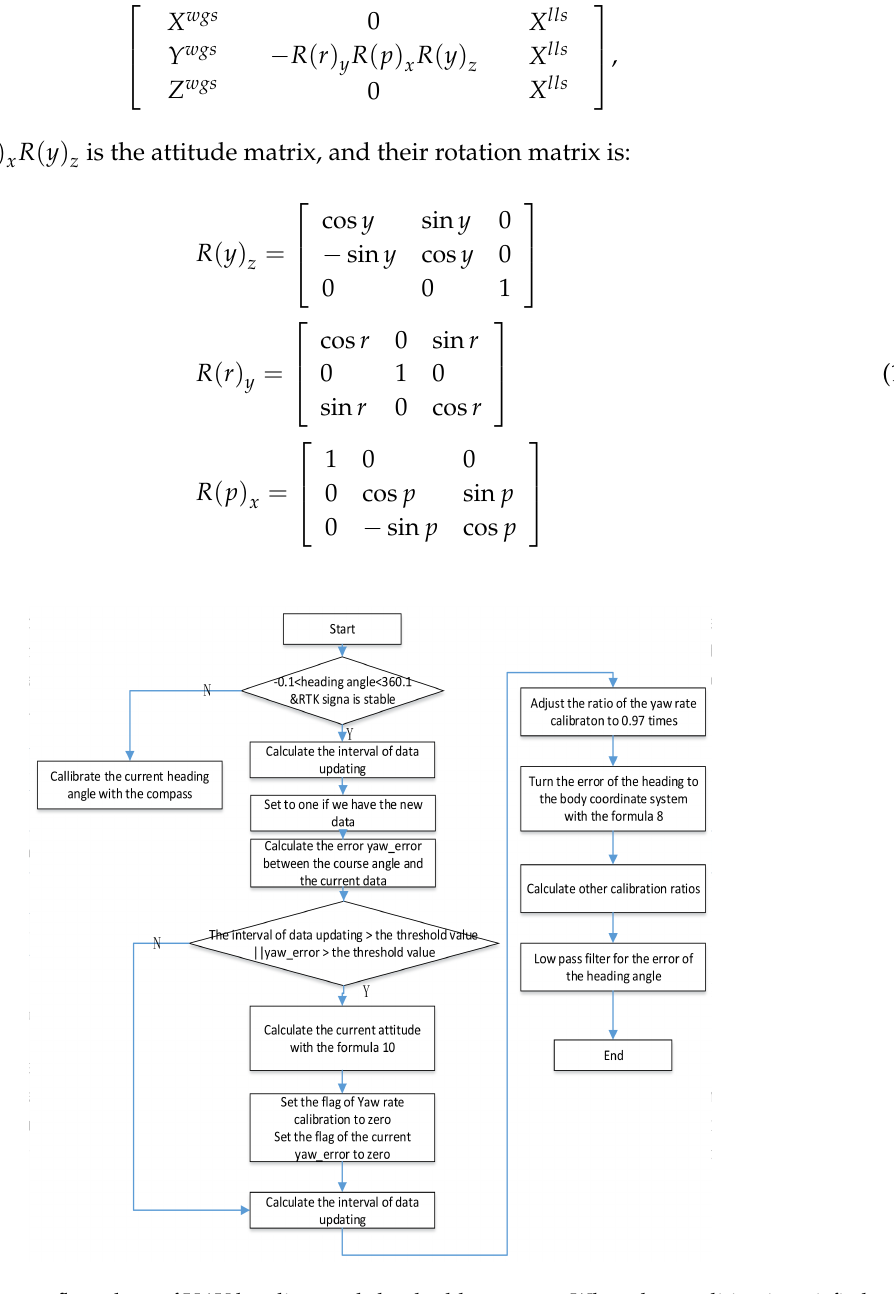
Figure 2. Program flow chart of UAV heading angle by double antenna. When the condition is satisfied, the calculation of rotation cosine matrix of the pitch and roll angles will be continued (using heading signal correction gyros drift). If there is no double antenna signal or the signal is not stable, we will continue to use the magnetic compass